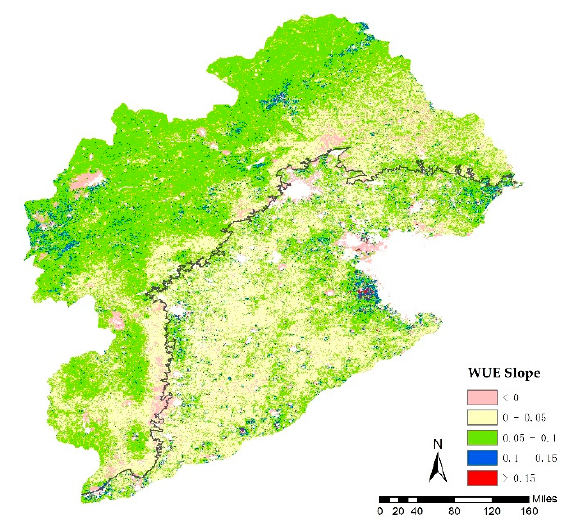
Figure 9. Spatial distribution of the slope of the WUE based on ordinary least squares (OLS) regression from 2005 to 2015 in the Haihe River Basin.